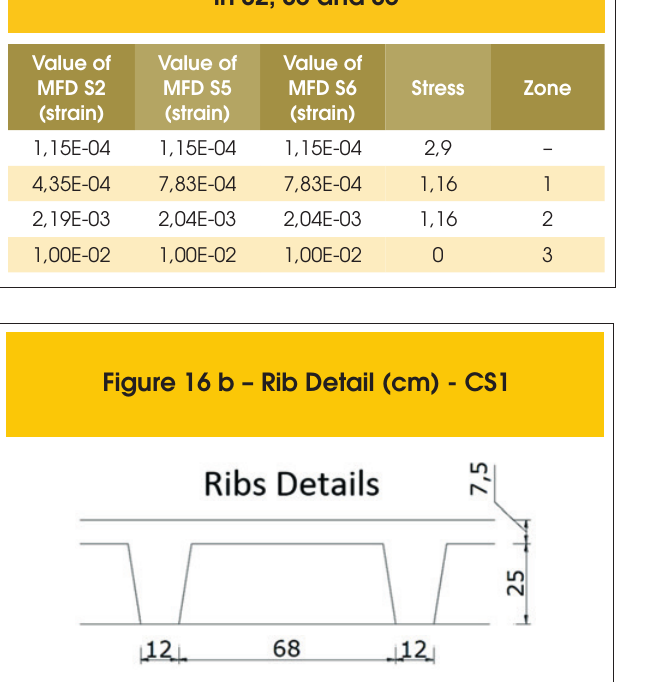
Tabela 4 – Stress-strain for cracked